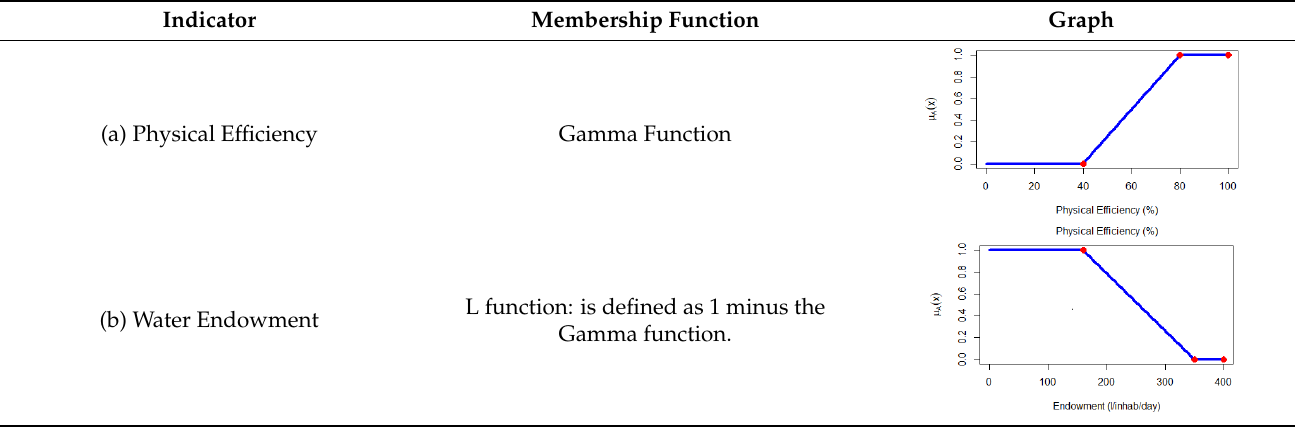
Table 3. Result of gamma membership functions.